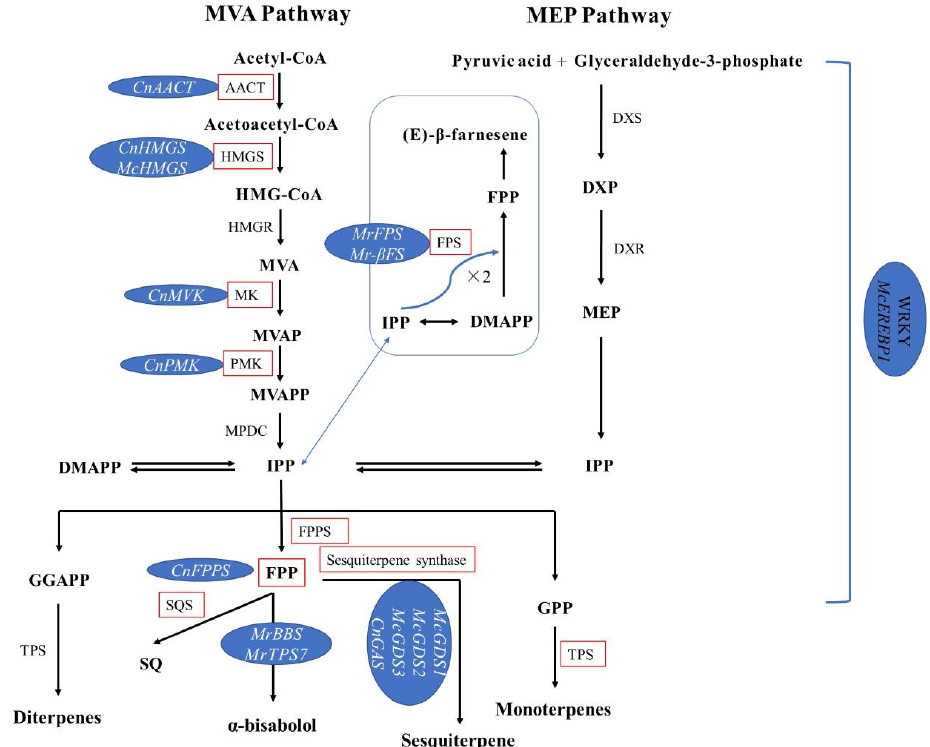
Figure 1. Terpenoid synthesis pathway in M. chamomilla . Enzyme abbreviations: AACT (acetyl-CoA C-acetyltransferase); DMAPP (dimethylallyl diphosphate); DXP (1-deoxy-xylose-5-phosphate); DXS (1-deoxy-D-xylulose 5-phosphate synthase); FPP (farnesyl pyrophosphate); FPPS (farnesyl pyrophosphate synthase); GGAPP (geranylgeranyl pyrophosphate); GPP (geranyl diphosphate); HMGR (3-hydroxy-3-methylglutaryl-CoA reductase); HMGS (3-hydroxy-3-methylglutaryl-CoA synthase); IPP (isoprene diphosphate); MEP (2-C-methyl-D-erythritol 4-phosphate); MK (MVA kinase); MPDC (diphospho-MVA decarboxylase); MVA (mevalonate); MVAP (mevalonate-5-pyrophosphate); MVAPP (mevalonate 5-diphosphate); PMK (phosphomevalonate kinase); SQ (squa- lene); SQS (squalene synthase); TPS (terpene synthase).